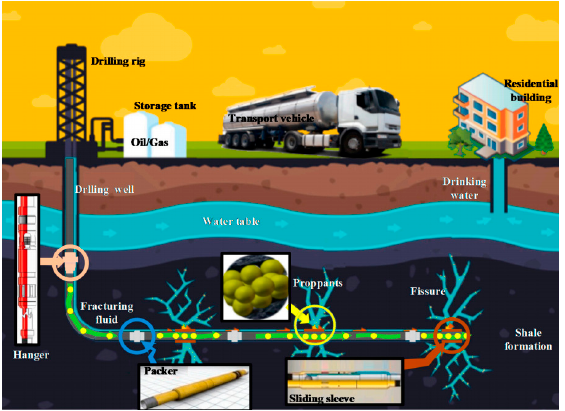
Figure 1. Schematic of the hydraulic fracturing process [1].